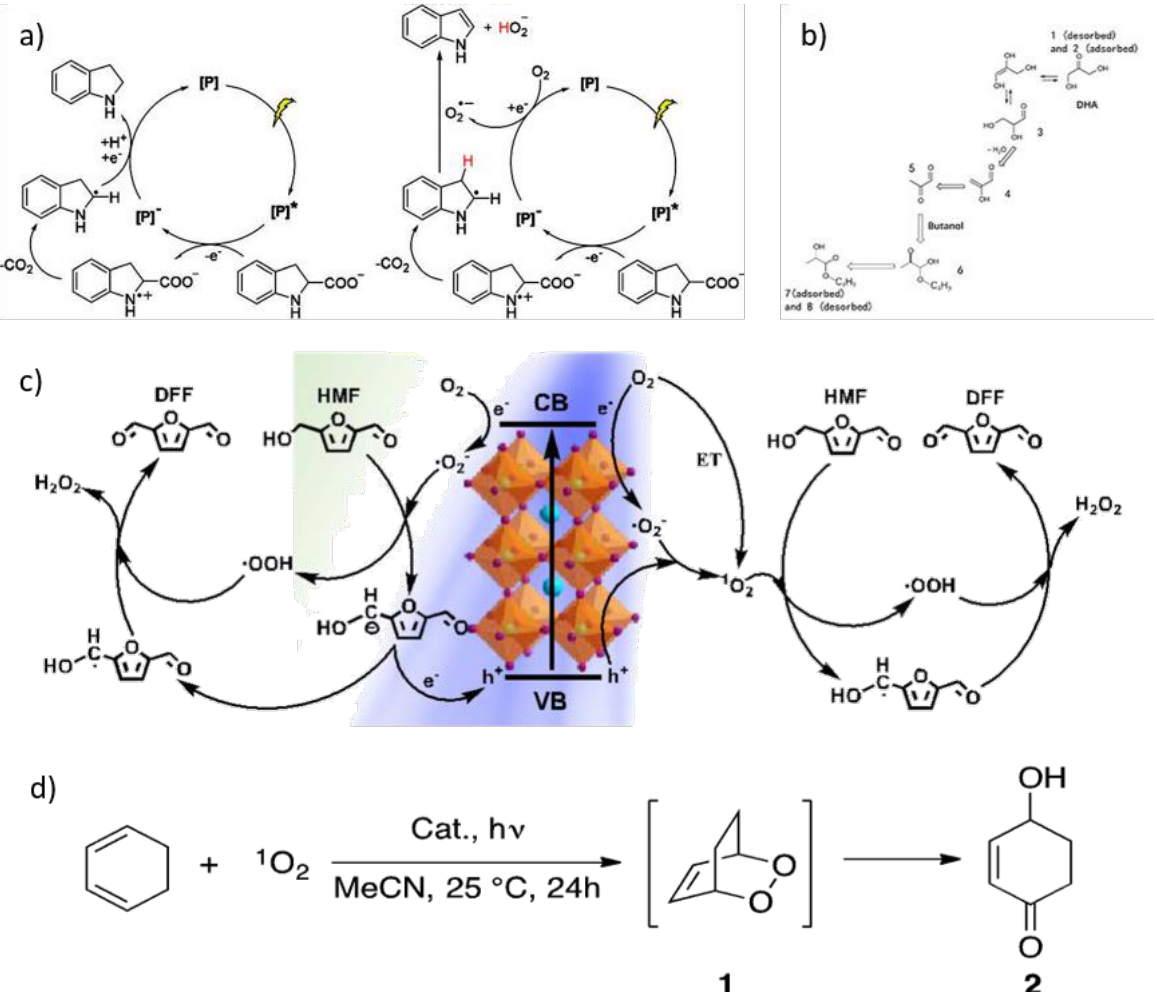
Figure 5. Proposed reaction mechanisms: ( a ) for the decarboxylation (left) and dehydrogenation (right) of indoline-2-carboxylic acid. For details, see ref [39]. Reprinted with permission from ref [39]. Copyright 2019 Angewandte Chemie International Edition. ( b ) for the conversion of DHA into butyl lactate. For details, see ref [41]. Reprinted with permission from ref [41]. Copyright 2020 Angewandte Chemie International Edition. ( c ) for the oxidation of HMF using MAPbBr 3 photocatalyst and atmospheric O 2 . For details, see ref [40]. Reprinted with permission from ref [40]. Copyright 2020 ACS Catalysis. ( d ) for the HDA cycloaddition reaction of 1,3-cyclohexadiene and 1 O 2 . For details, see ref [42]. Reprinted with permission from ref [42]. Copyright 2021 Catalysis Science & Technology.